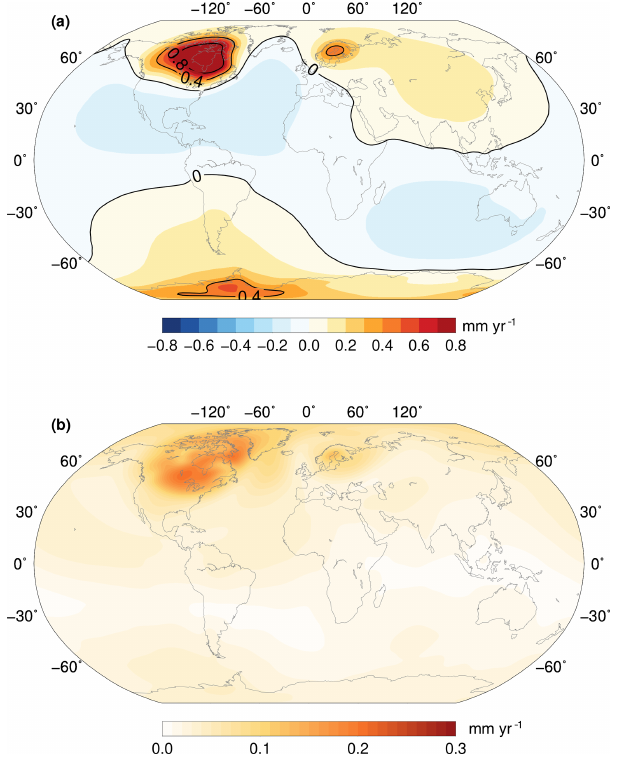
Figure 1. Ensemble GIA solution (a) and 1 standard deviation (b) in terms of geoid height